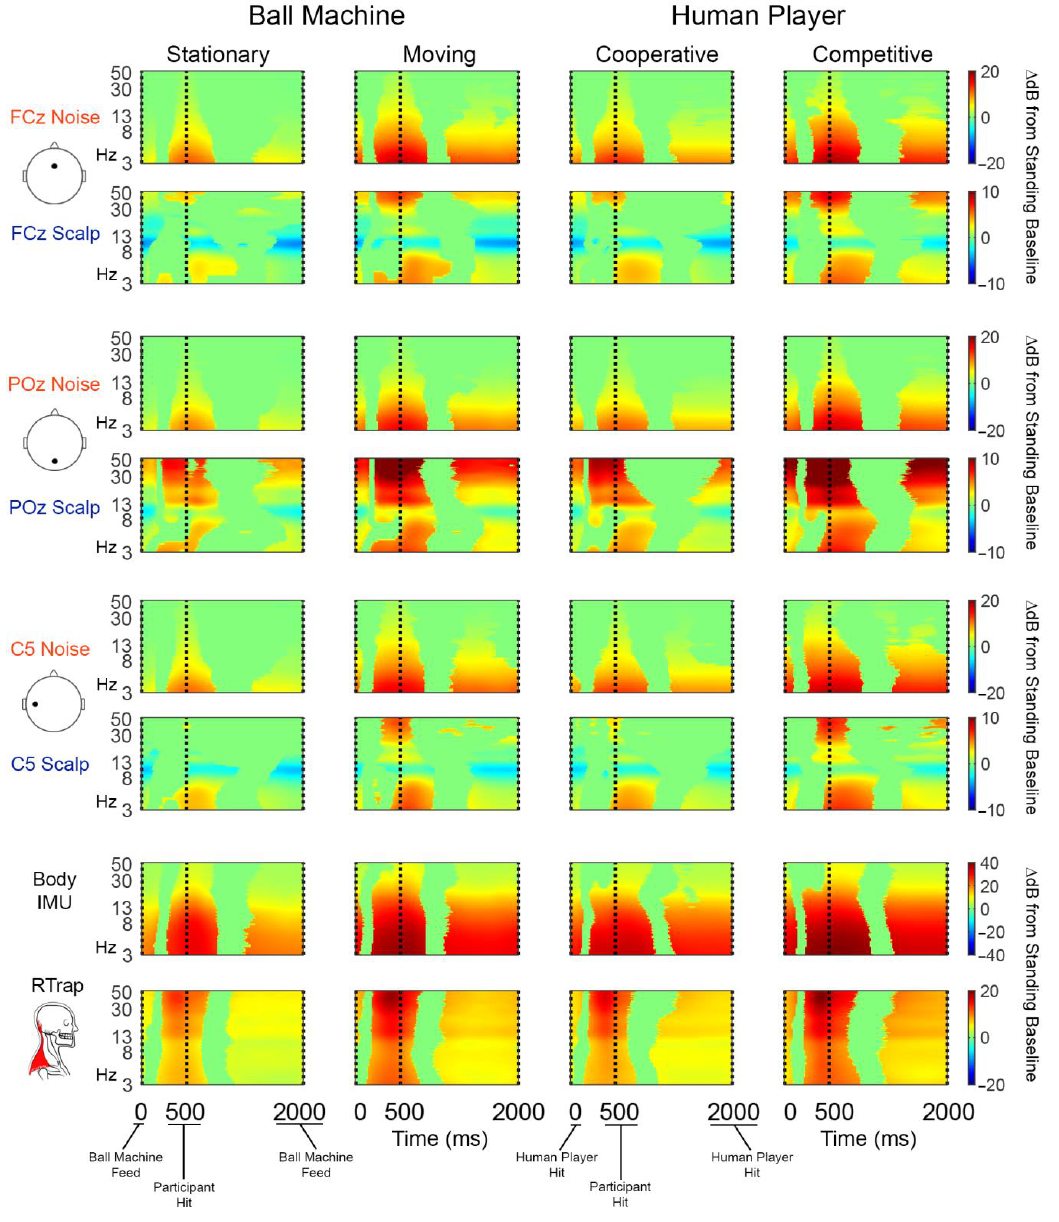
Figure 5. Group average ( n = 20) event-related spectral perturbation (time-frequency) plots. Noise electrodes are in rows 1, 3, and 5. Scalp-matched electrodes are shown in rows 2, 4, and 6. The body IMU and right trapezius (RTrap) are shown in rows 7 and 8, respectively. Each hitting condition is shown in a different column. Significant increases in spectral power relative to standing baseline are in red and significant decreases in power relative to standing baseline are in blue. Vertical dashed lines indicate events in a single “swing cycle”. We defined a “swing cycle” as three events: (1) when the ball was presented to the participant as a ball machine feed or human player hit, (2) when the participant hit the ball, and (3) when the ball was presented to the participant for the next